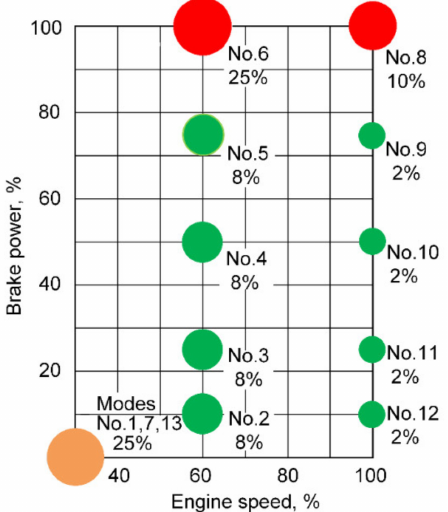
Figure 3. Distribution of operation points in the 13-mode steady-state test cycle ECE R49 for vehicle diesel engine. The percentage near each mode is the mode time-share (weighting factor). Red color—full load; green color—part load; orange